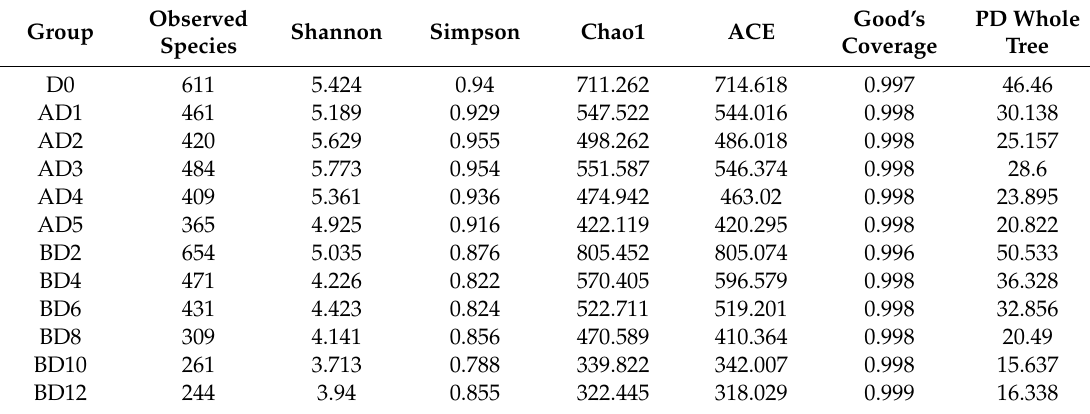
Table 1. The alpha diversity index (all samples).